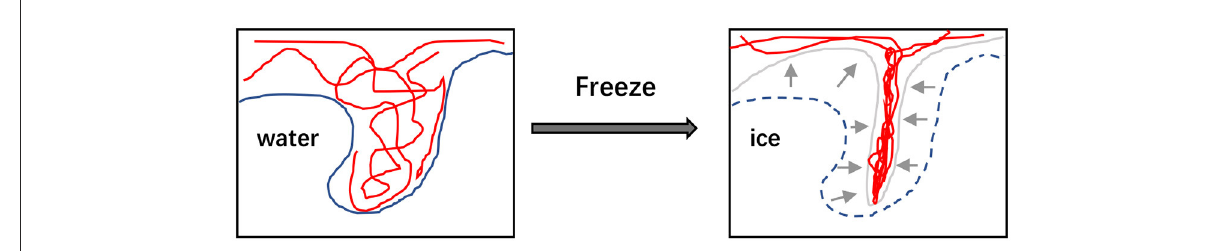
FIGURE2 The illustration that freezethaw cycles would reform the microstructure of polymer